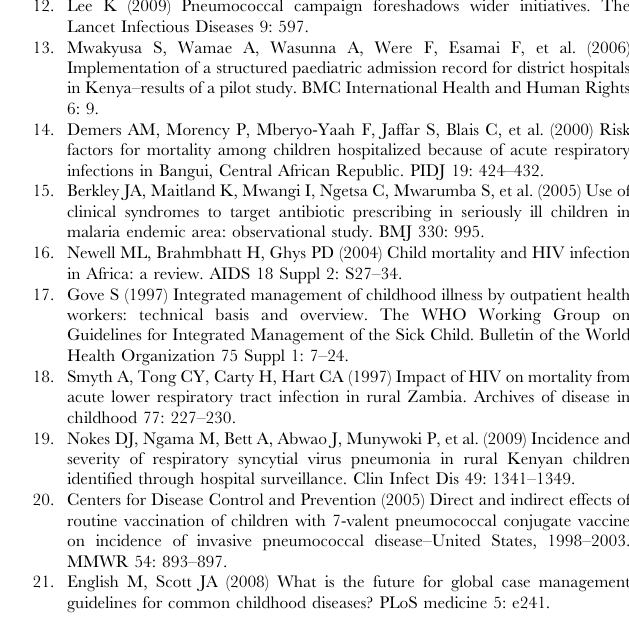
Table S1 Sensitivity analysis of the impact of different user defined weights for H9 on model estimates of effect of age, sex, and comorbidity on pneumonia